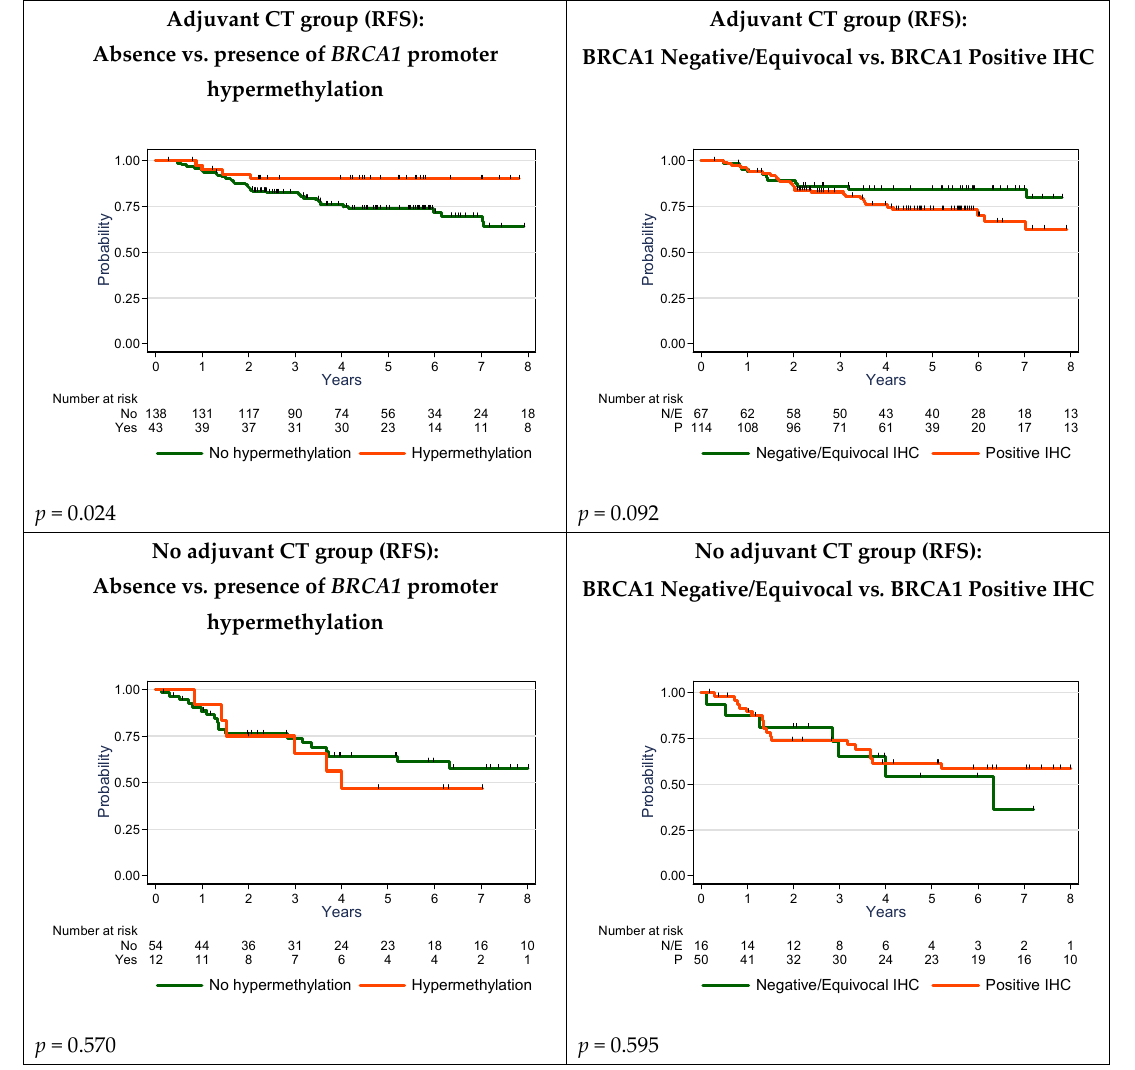
Figure 4. Relapse-Free Survival (RFS) in adjuvant chemotherapy-treated and untreated patients by BRCA1 immunohistochemistry (IHC) expression and BRCA1 promoter hypermethylation.